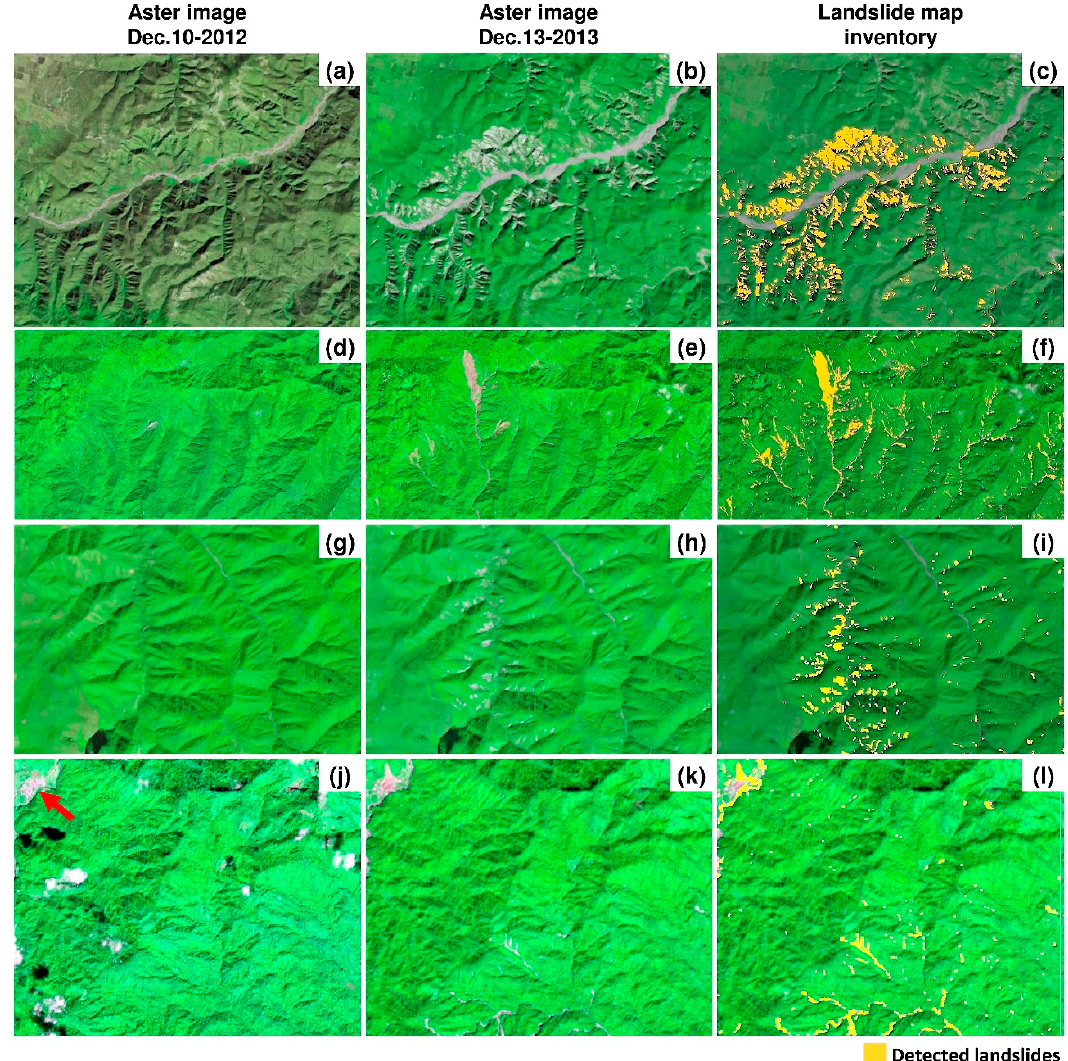
Figure 15. Landslide zoomed areas. ( a , d , g , j ) Aster Images from 10 December 2012 (before the events of September 2013). ( b , e , h , k ) Aster images from 13 December 2013 (after the events of September 2013). ( c , f , i , l ) Final landslide inventory map (in yellow color) superimposed on the post-Aster image.